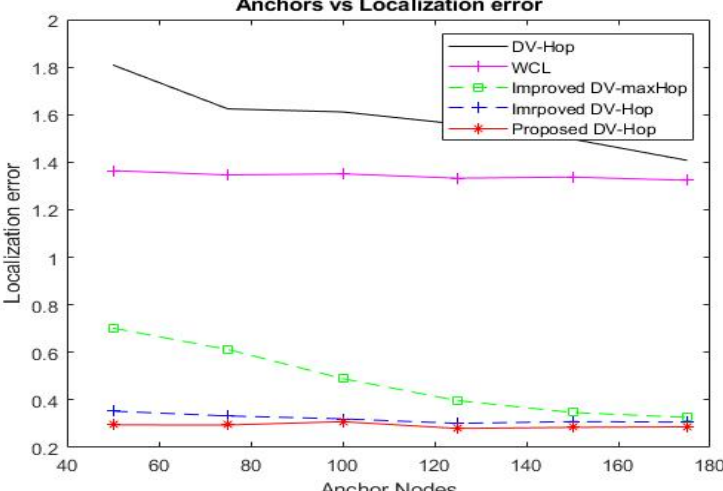
Figure 9. Simulation results for localization error using various anchor ratios.